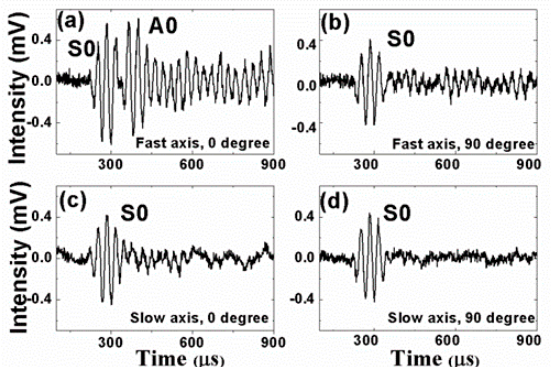
Figure 5. Responses of the Polarization-maintaining Fiber Bragg grating under 30 kHz actuation to ( a ) 0-degree excitation and fast-axis detection; ( b ) 90-degree excitation and fast-axis detection; ( c ) 0-degree excitation and slow-axis detection; and ( d ) 90-degree excitation and slow-axis